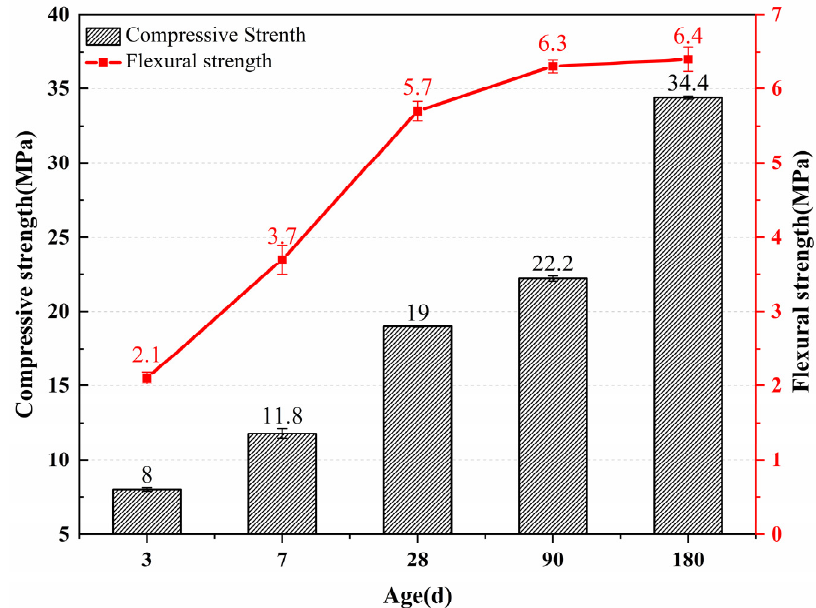
Figure 7. Compressive and flexural strength of the self-made cement